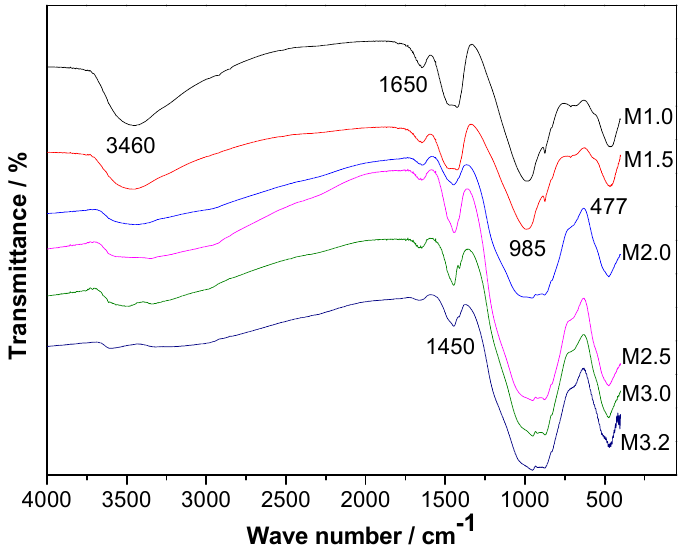
Figure 7. FT − IR spectra of alkali-activated CNS materials after hydration using sodium silicate solution with different moduli.